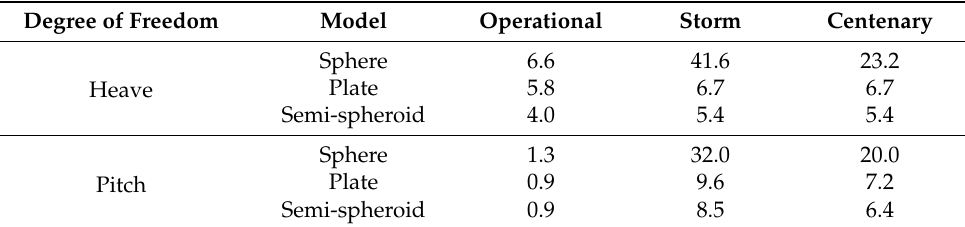
Table 12. In the model scale, the significant height of spectral crossing results in heave and pitch motions, H 33 [mm] and H 55